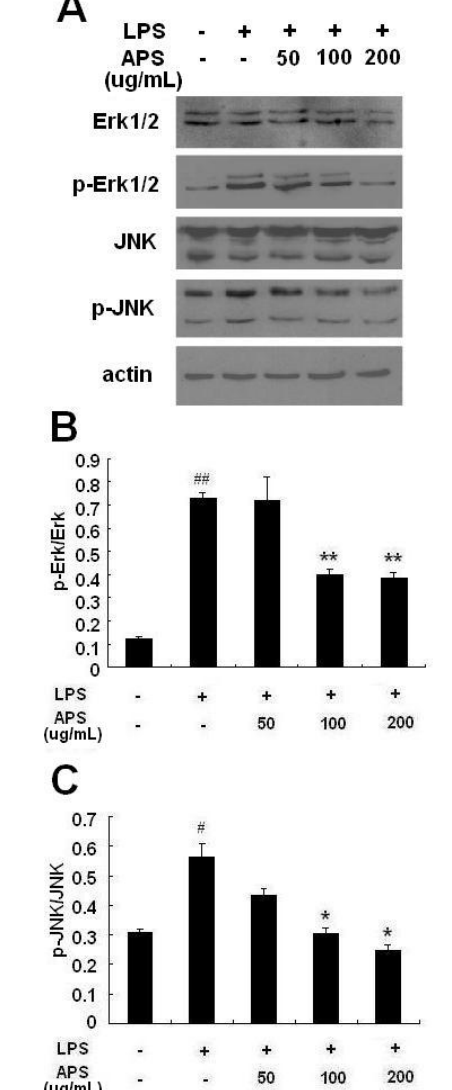
Figure 5. APS inhibited phosphorylation of MAPKs in LPS-stimulated THP-1 cells. THP-1 cells were treated with LPS (1 μ g/mL) and different concentration of APS (0, 50, 100 and 200 μ g/mL) for 24 h at 37 °C. The cells were then collected and extracted. Western blot analysis was performed to detect p-ERK, total ERK, p-JNK, total JNK and β -actin. ( A ) Western blot of the MAPKs isoforms: A representative result out of three experiments; ( B ) relative ratio of p-ERK/ERK; ( C ) relative ratio of p-JNK/JNK. * p < 0.05, ** p < 0.01, vs . LPS group; # p < 0.05, ## p < 0.01, vs . blank control group. Data are presented as mean ± S.D., and the data shown are representative of three independent